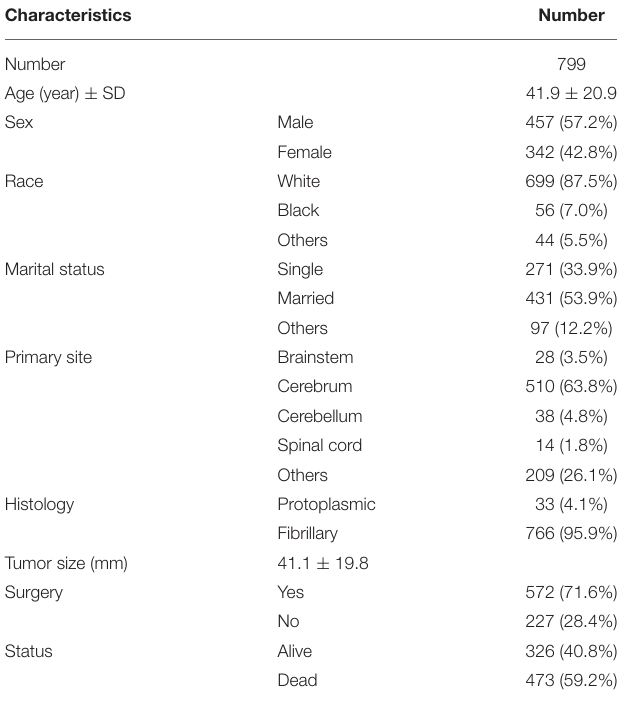
TABLE 1 | Characteristics of patients with diffuse